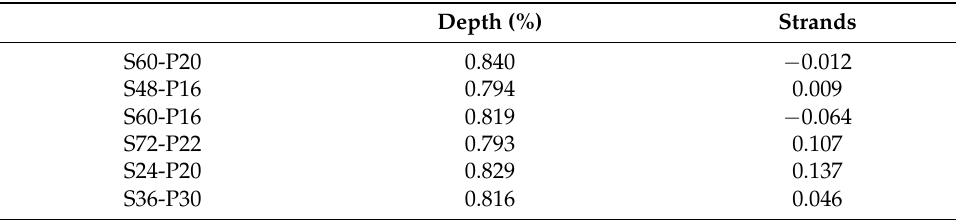
Table 5. Correlation analysis of the slot opening parameter and AC losses. Depth (%) Strands